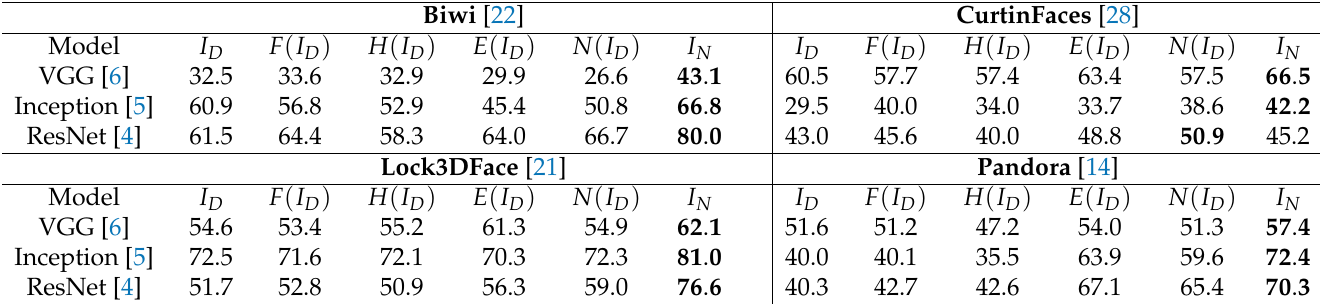
Table 3. Intra-dataset results, in terms of recognition accuracy, using depth and normal images ( I D and I N ). Pre-processing steps applied on depth images, i.e., filtering ( F ( I D ) ), hole filling ( H ( I D ) ), equalization ( E ( I D ) ), and data normalization ( N ( I D ) ), are also reported for depth map representation.